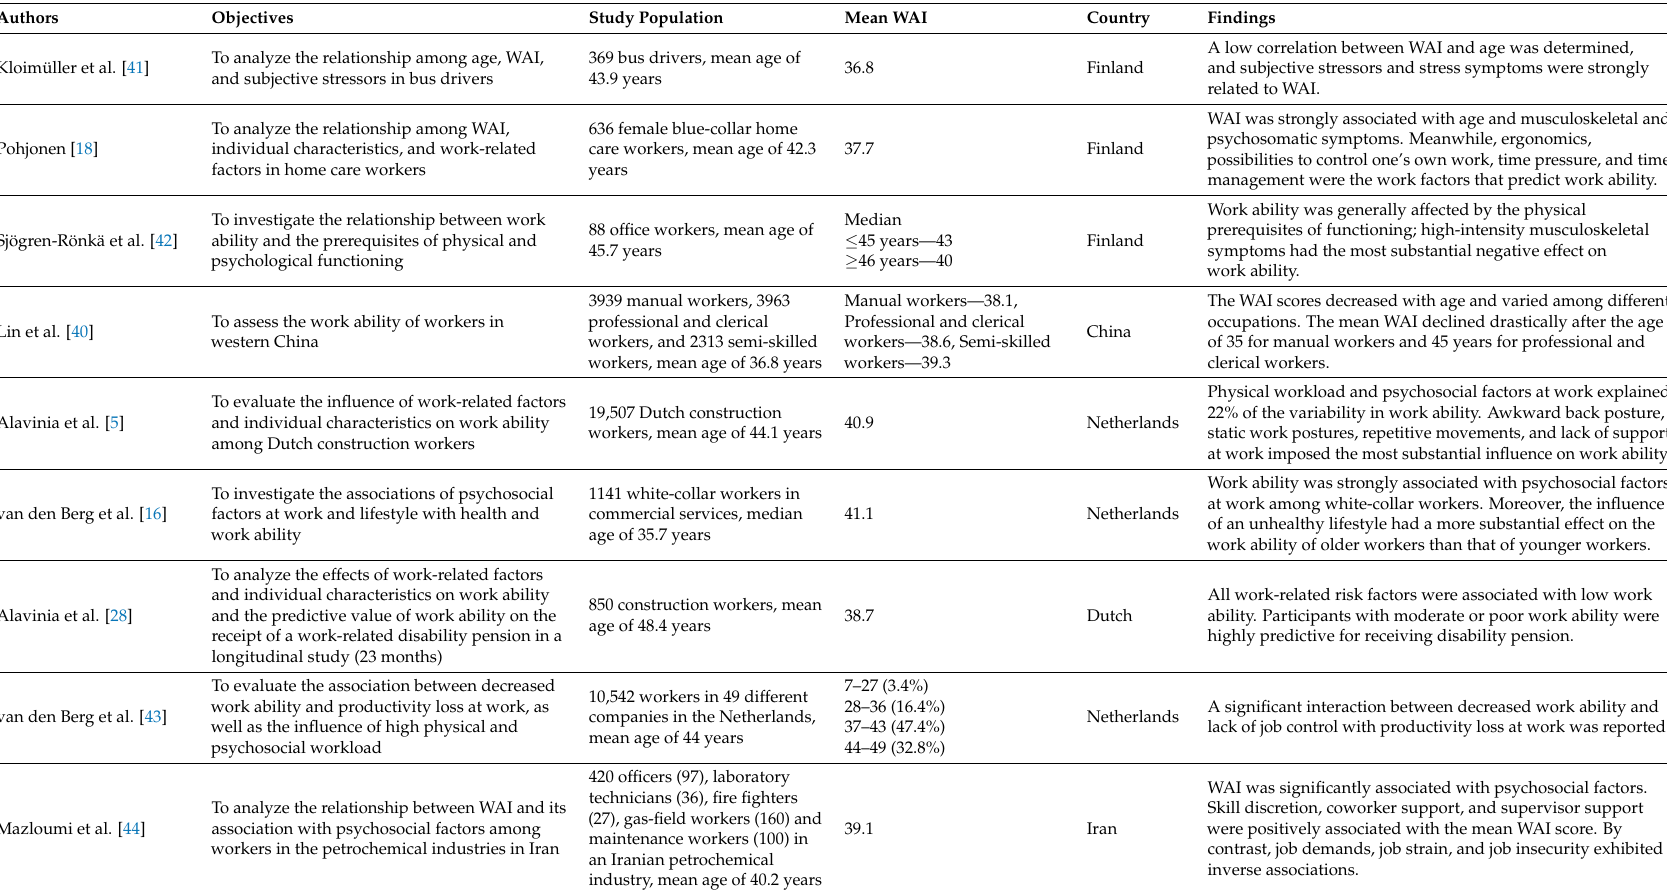
Table 1. The Work Ability Index (WAI) scores of workers of different occupations in various countries (from 2000 to